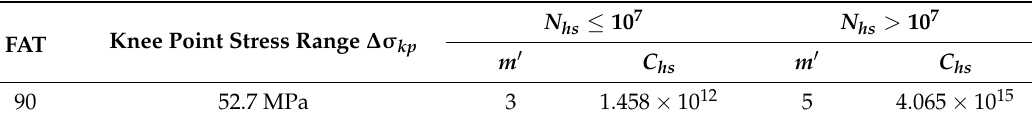
Table 5. Fatigue assessment result based on hot spot stress method.